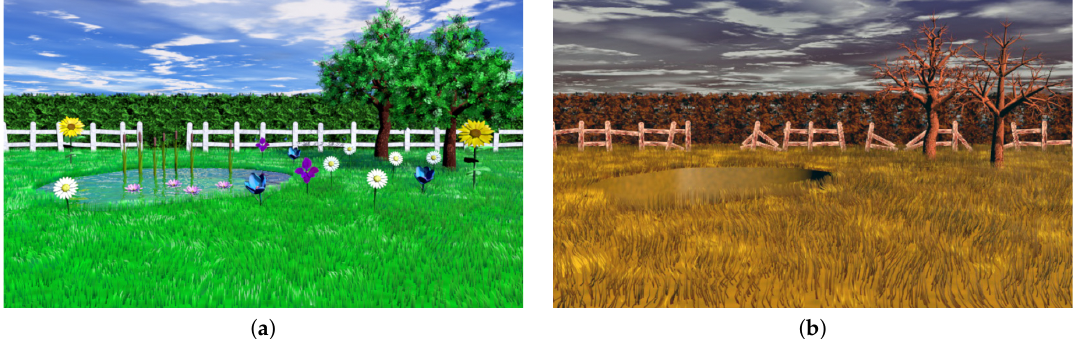
Figure 6. An example of an eco-visualization showing a green meadow ( a ), which can gradually die ( b ) because of the users’ energy consumption behavior. Images from Reference